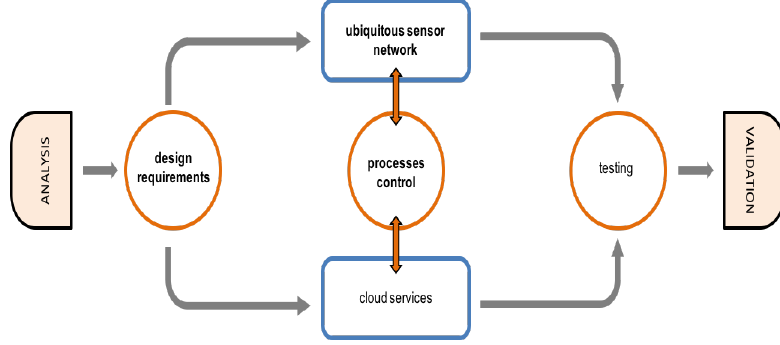
Figure 3. Design and development: project